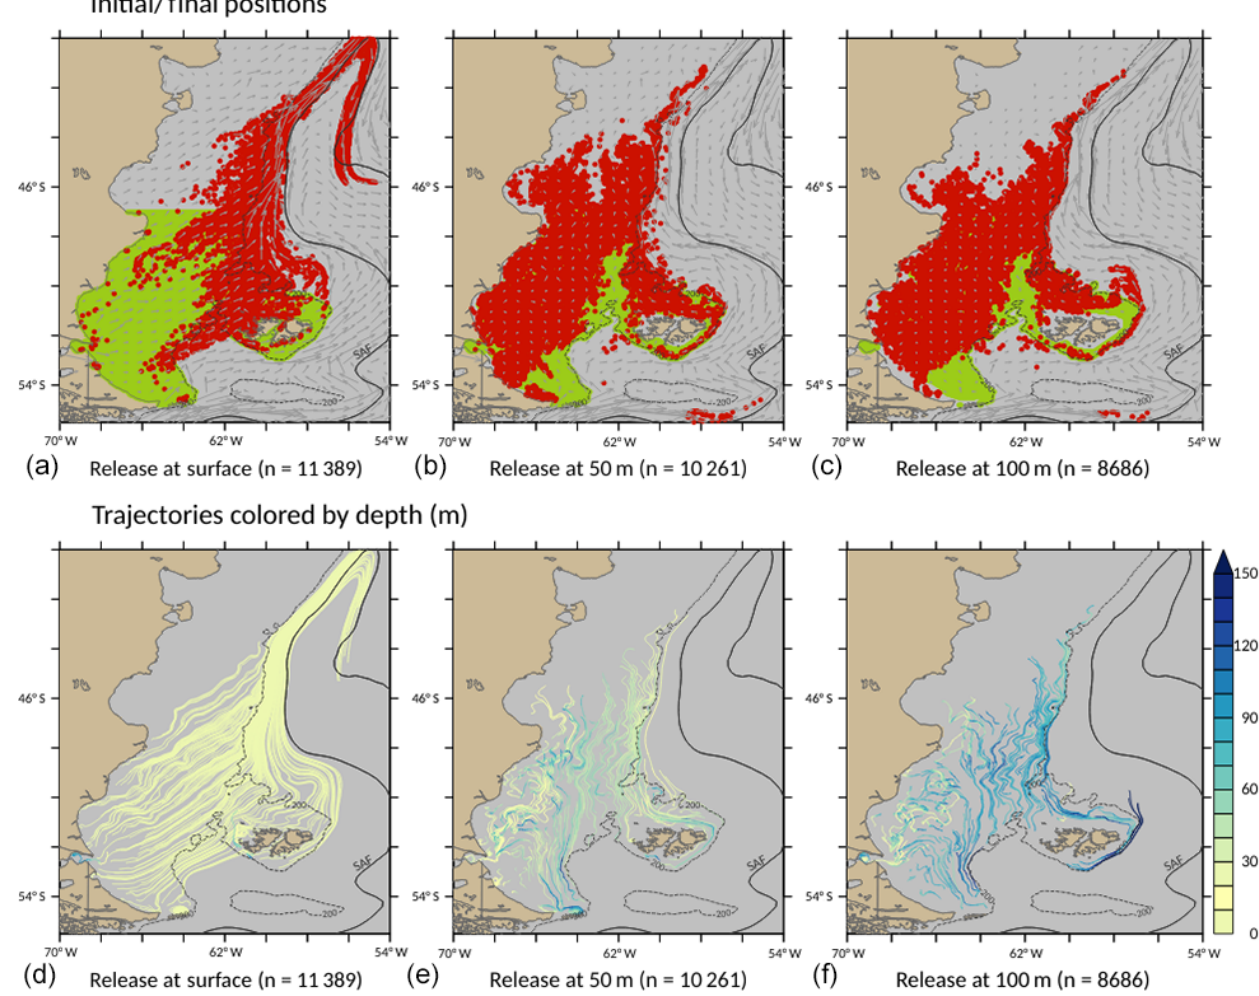
Figure 5. Forward Lagrangian advection of particles during 90d released on the PS. Initial positions (green) and final positions (red) of particles released at 0m (a) , 50m (b) , and 100m (c) . Vectors show the velocity at each depth. Particle trajectories colored by depth (m) for initial release at 0m (d) , 50m (e) , and 100m (f) (1 out of 20 trajectories shown). The number of particles ( n ) for each experiment is shown, and the SAF is indicated in